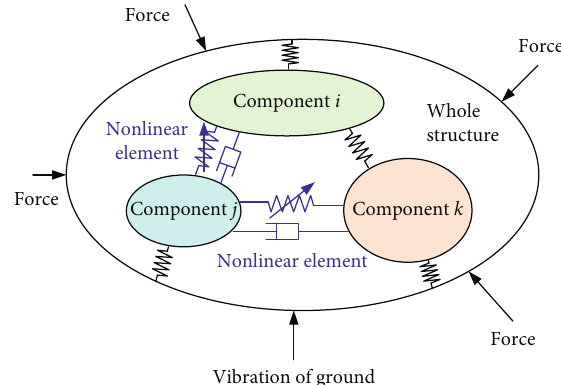
Figure 1: Illustration of the nonlinear spring-damping elements for the jointed